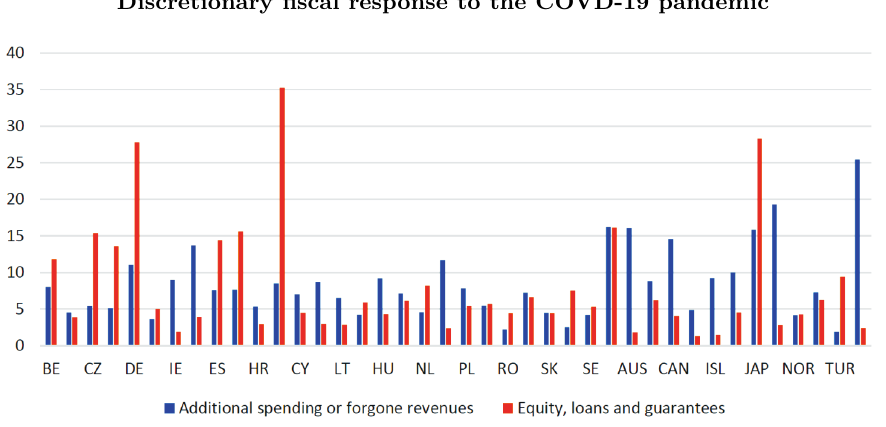
Factors Determing the COVID-19 Fiscal Stimulus Packages... Discretionary fiscal response to the COVD-19